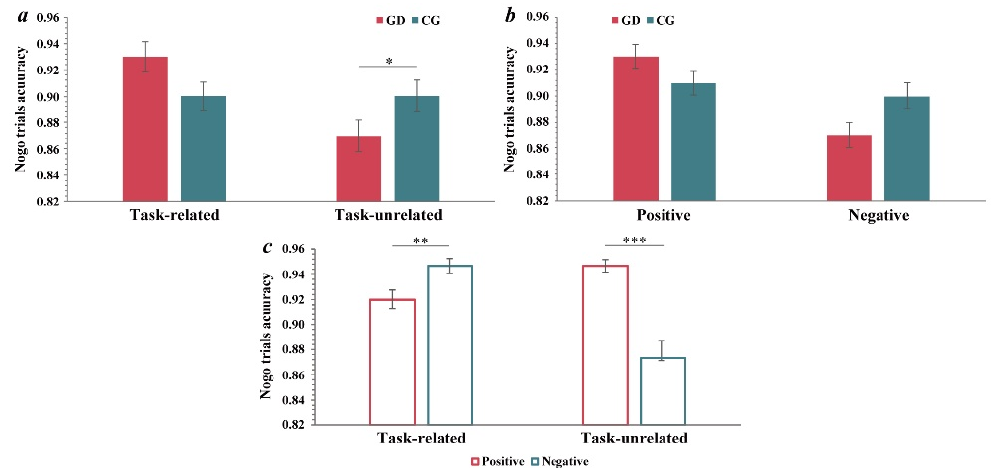
Figure 2. ( a ) Task × group interaction. ( b ) Valence × group interaction. ( c ) Task × valence interaction. GD = gaming disorder group, CG = control group. The error bars stand for the standard deviation of the means. * p < 0.05, ** p < 0.01, *** p < 0.001.